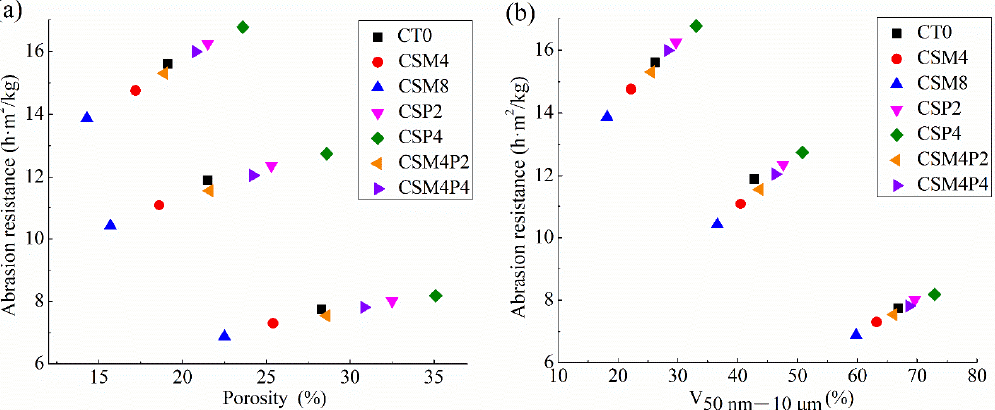
Figure 10. The relationship between the abrasion resistance and ( a ) porosity and ( b ) V 50 nm–10 μ m of hydraulic concretes containing MgO and/or PVA fiber.